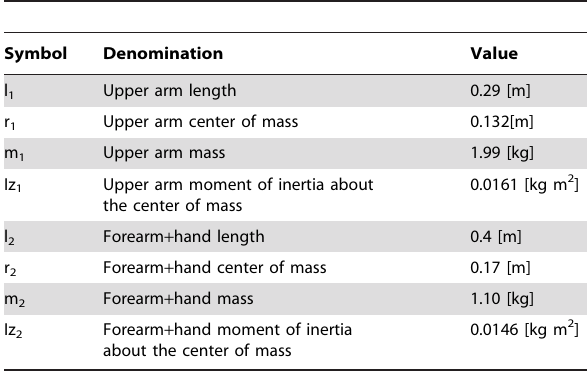
Table 1. Inertial and geometrical parameters used in the